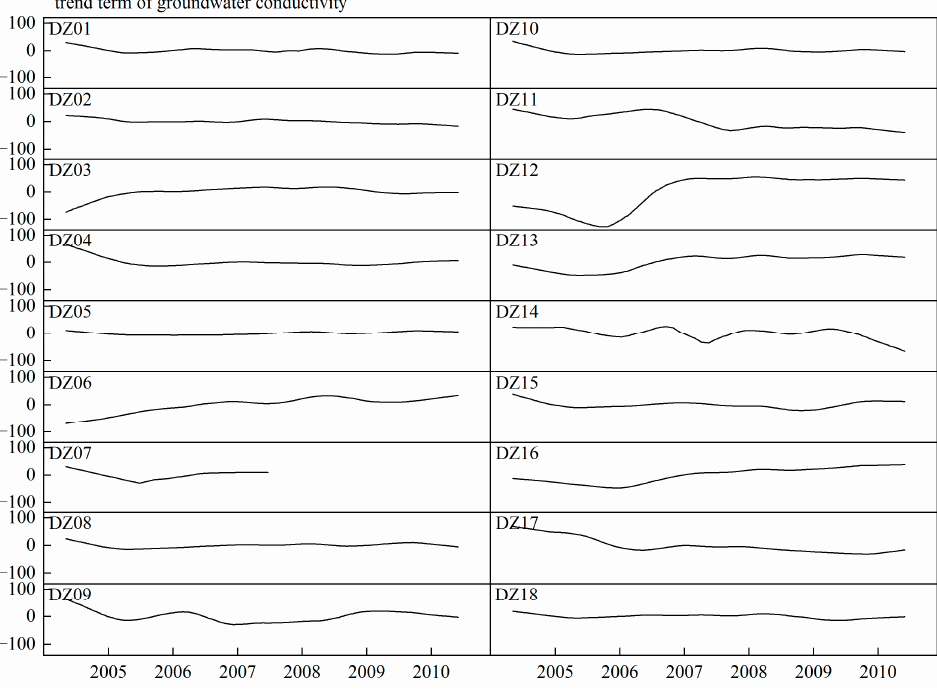
Figure A2. The trend term of groundwater EC of each observational well varies with time.